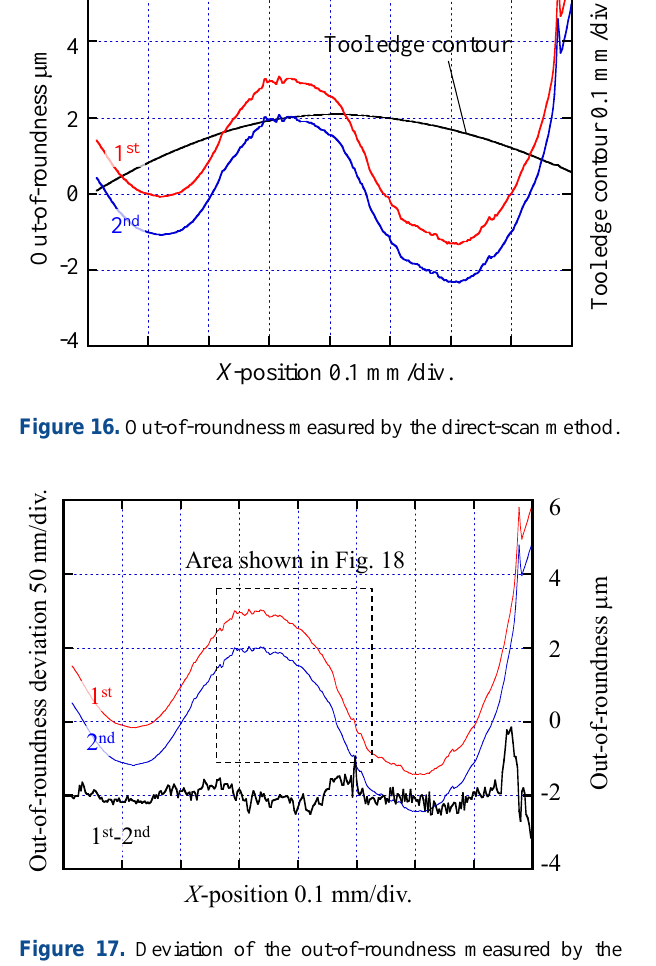
Figure 15. Edge contour of the round cutting edge measured by the direct-scan method.